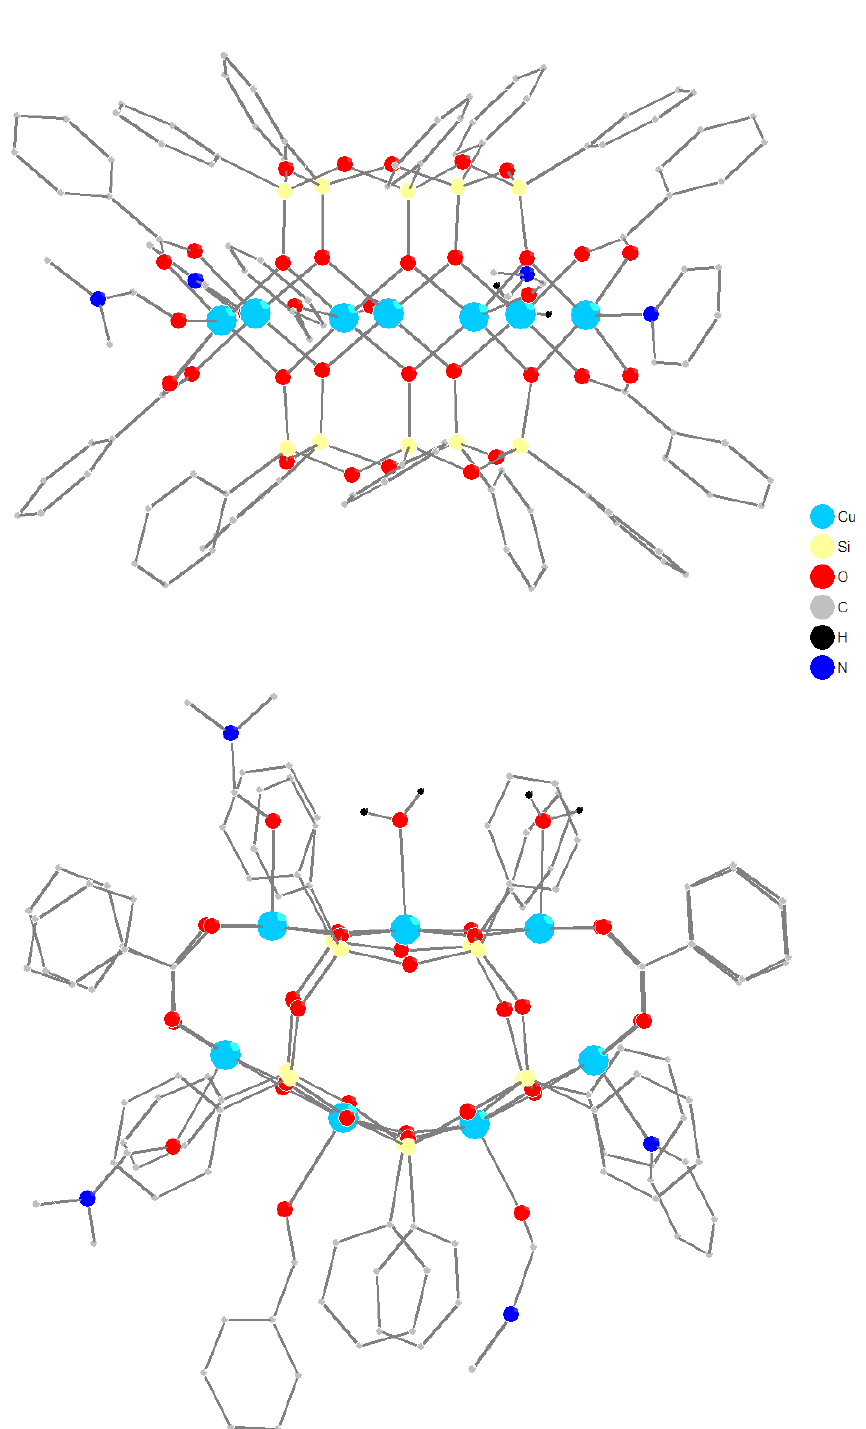
Figure 1. Side ( top ) and top ( bottom ) views of the molecular structure of 1. On the other hand, the multiplicity of the ligand set (as well as the necessity of prelim- inary toluene oxidations) prevents a high yield of complex 1 . To overcome this issue, we performed additional reaction runs with a precise stoichiometric ratio of key components according to the as-received composition of 1 (10Si:7Cu:4benzoates). Using benzoic acid as a reagent (Scheme 1), two analogs of complex 1 were successfully prepared. More precisely, complex 2 (Figure 3) of [(Ph 5 Si 5 O 10 ) 2 ][PhCOO] 4 Cu 7 (DMSO) 2 (EtOH) 4 composition was isolated in a 36% yield from ethanol/dimethylsulfoxide solvate system.